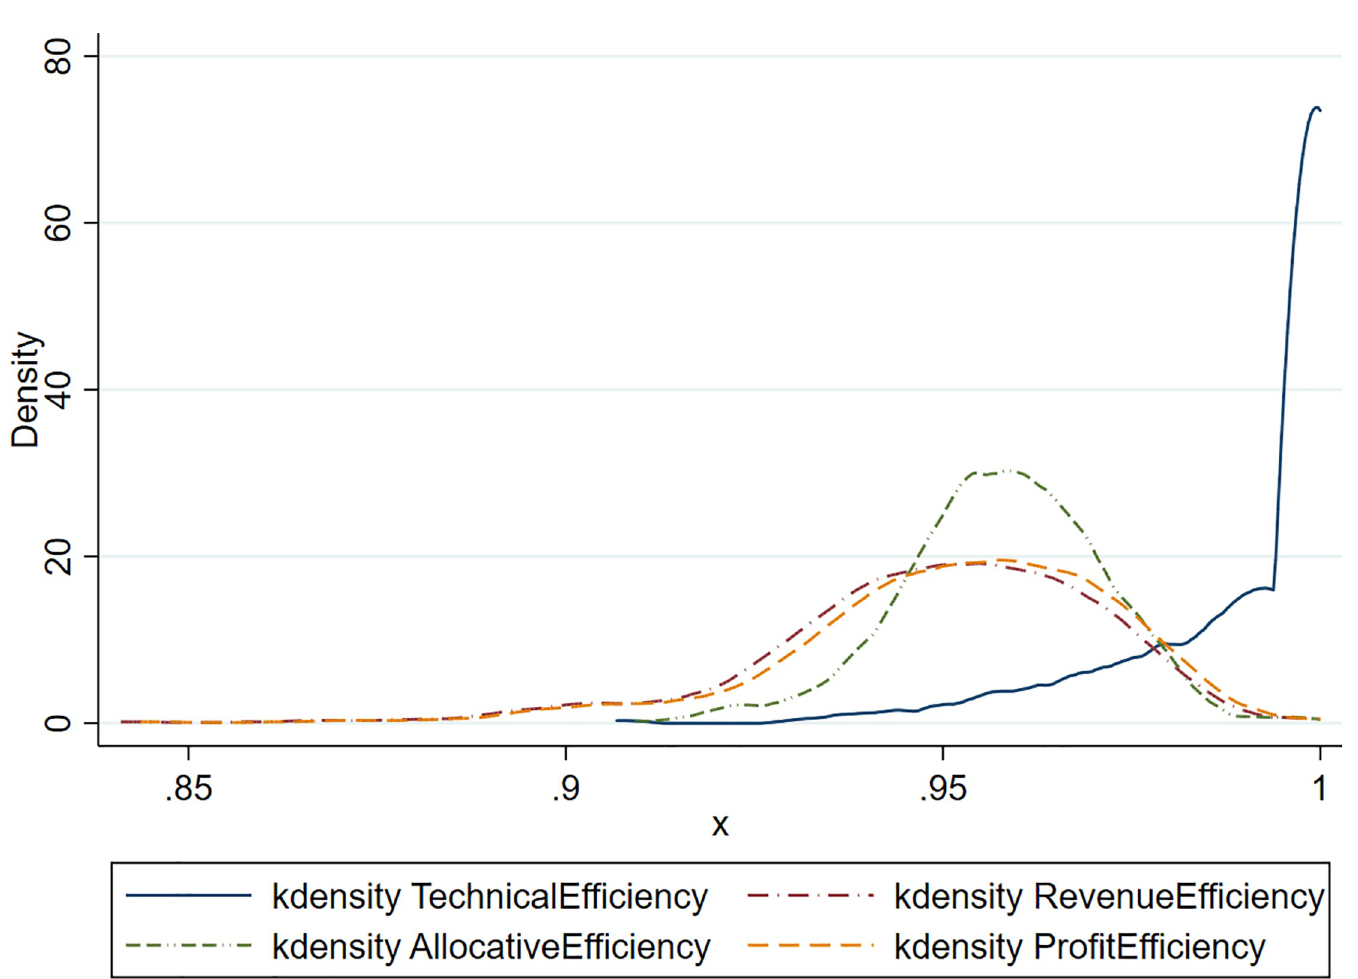
PLOS ONE | https://doi.org/10.1371/journal.pone.0223436 November11,